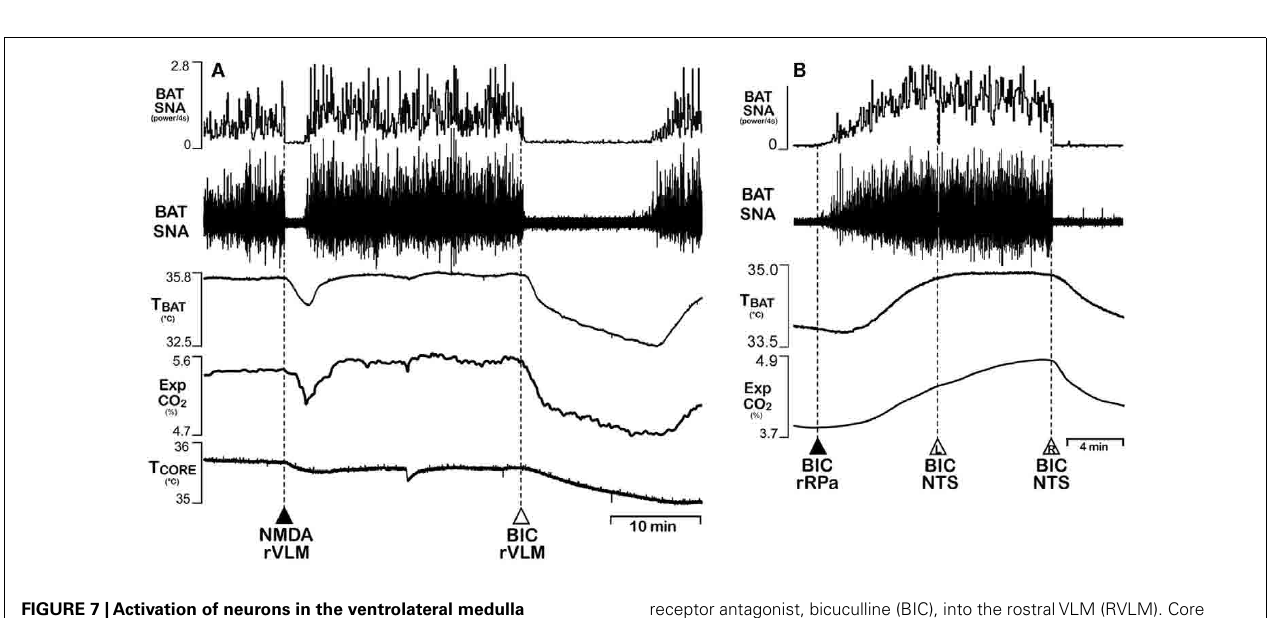
FIGURE 6 | Disinhibition of neurons in the paraventricular hypothalamic (PVH) nucleus inhibits the increases in BAT sympathetic nerve activity (SNA) evoked by cooling, but not those evoked by disinhibition of neurons in the rostral raphe pallidus (rRPa). (A) Nanoinjection of bicuculline (BIC) into the PVH completely reversed the increases in BAT SNA, BAT temperature (TBAT), expired CO 2 (Exp CO 2 )